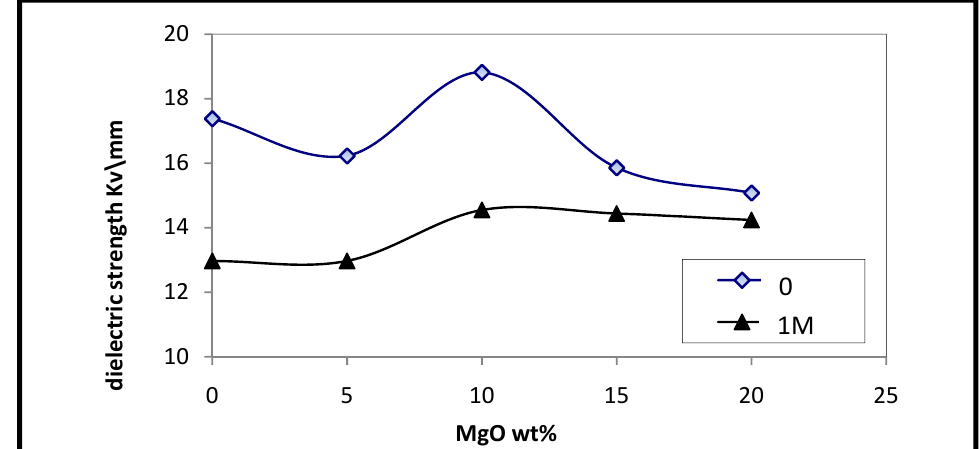
Fig. 3: The variation of dielectric strength as a function of MgO wt.% content